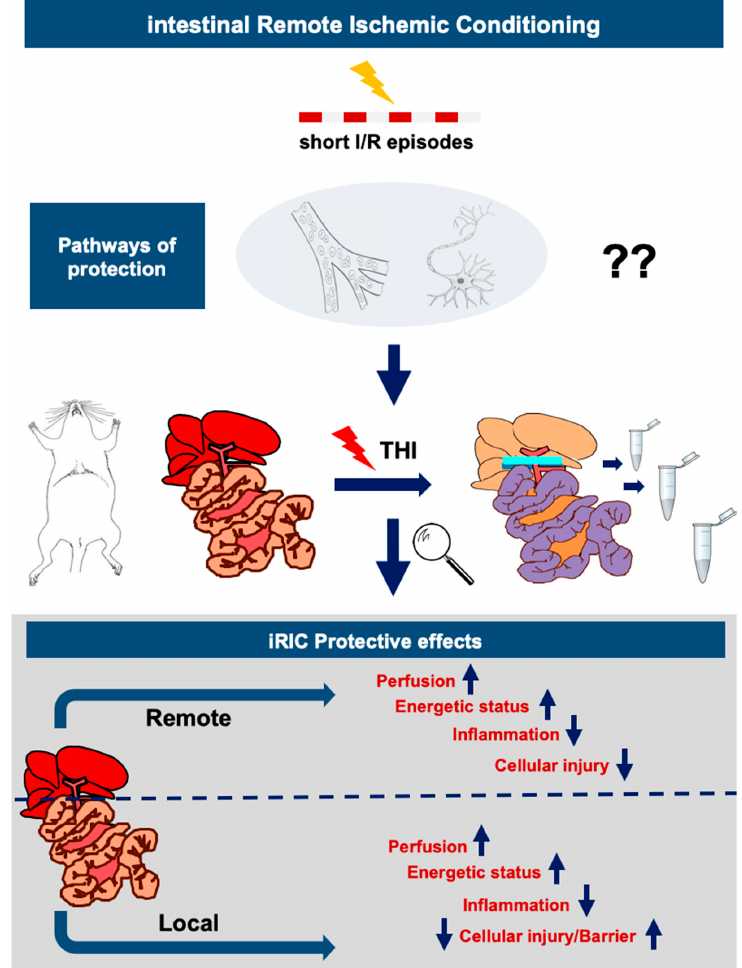
Figure 7. Summary of the mechanism and effects of iRIC observed in the setting of THI in rats. The following flowchart depicts the observed and possible protective effects and mechanisms of action of iRIC following THI in rats. Briefly, iRIC applied as short periods of ischemia-reperfusion before THI at a remote organ (intestine) results in the transfer of protective signals via different humoral and/or neural and partially unknown connective mechanisms to the target organ (liver), however, it seemingly also confers a local protection against the detrimental effects of intestinal congestion and functional ischemia of the gut, via preserving the integrity of the intestinal tissue and barrier function and resulting in less dramatic systemic effects of THl. Adapted from Emotzpohl, Czigany et al. Shock. 2018 [15]. Abbreviations used: iRIC—Intestinal remote ischemic conditioning; THI—Total hepatic ischemia.